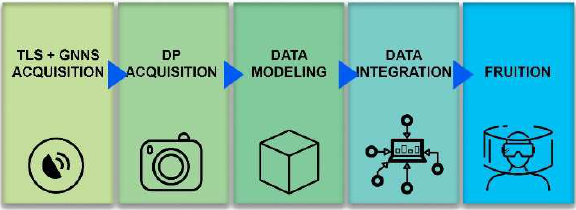
Figure 1: Workflow. 1) acquisition through use of TLS and GNNS methods, 2) digital photogrammetry acquisition, 3) data elaboration and modelling, 4) data integration and 5) fruition with VR